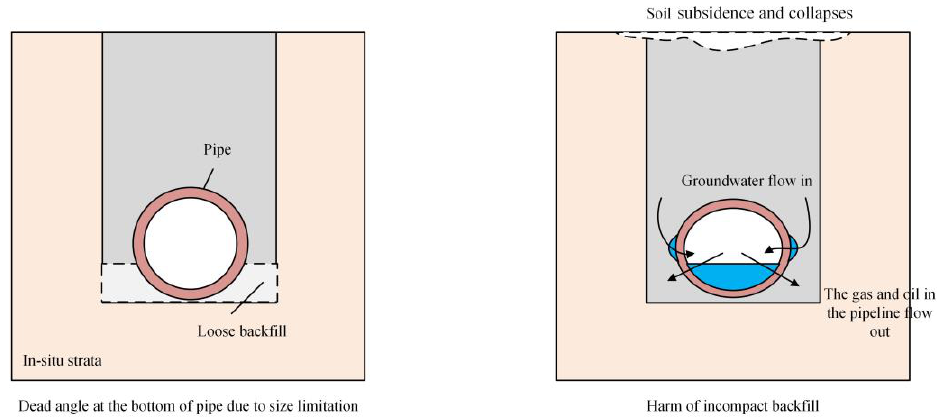
Figure 1. A typical illustration of the incompact backfill.